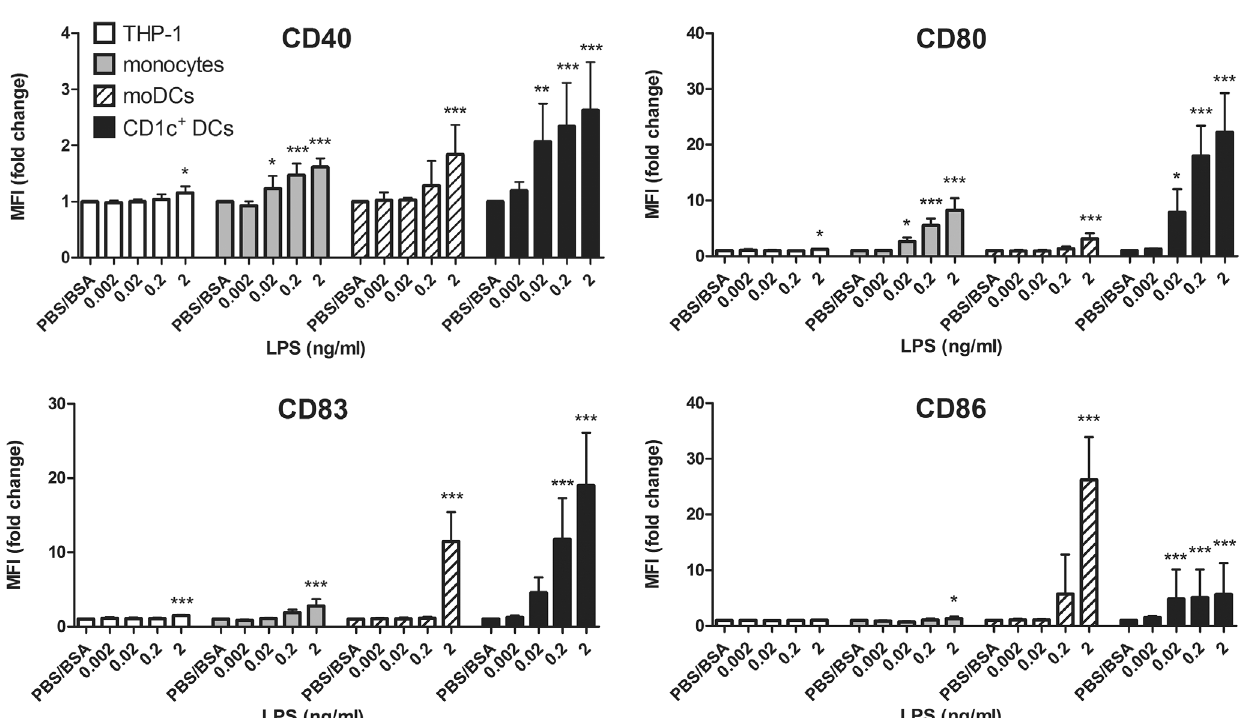
Figure 4. Surface marker expression upon stimulation with low LPS concentrations. Cells were plated and induced as described in Figure 3. After 16 h of induction, cells were harvested and stained for the expression of surface markers using appropriate amounts of fluorescent-labelled antibodies. The median of the fluorescence intensities of 1 6 10 4 cells each was recorded by flow cytometry. Fold change values were calculated to compare individual cell types with different compensation settings. Results show mean and SD of at least four independent experiments per cell type. Statistical analysis was performed as described in Figure